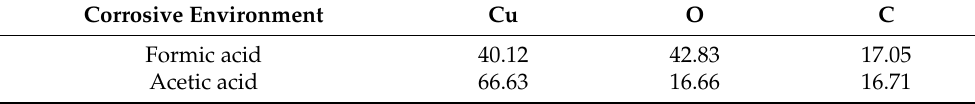
Table 4. Surface energy spectrum results of copper exposed to organic acids for 30 days (wt%).